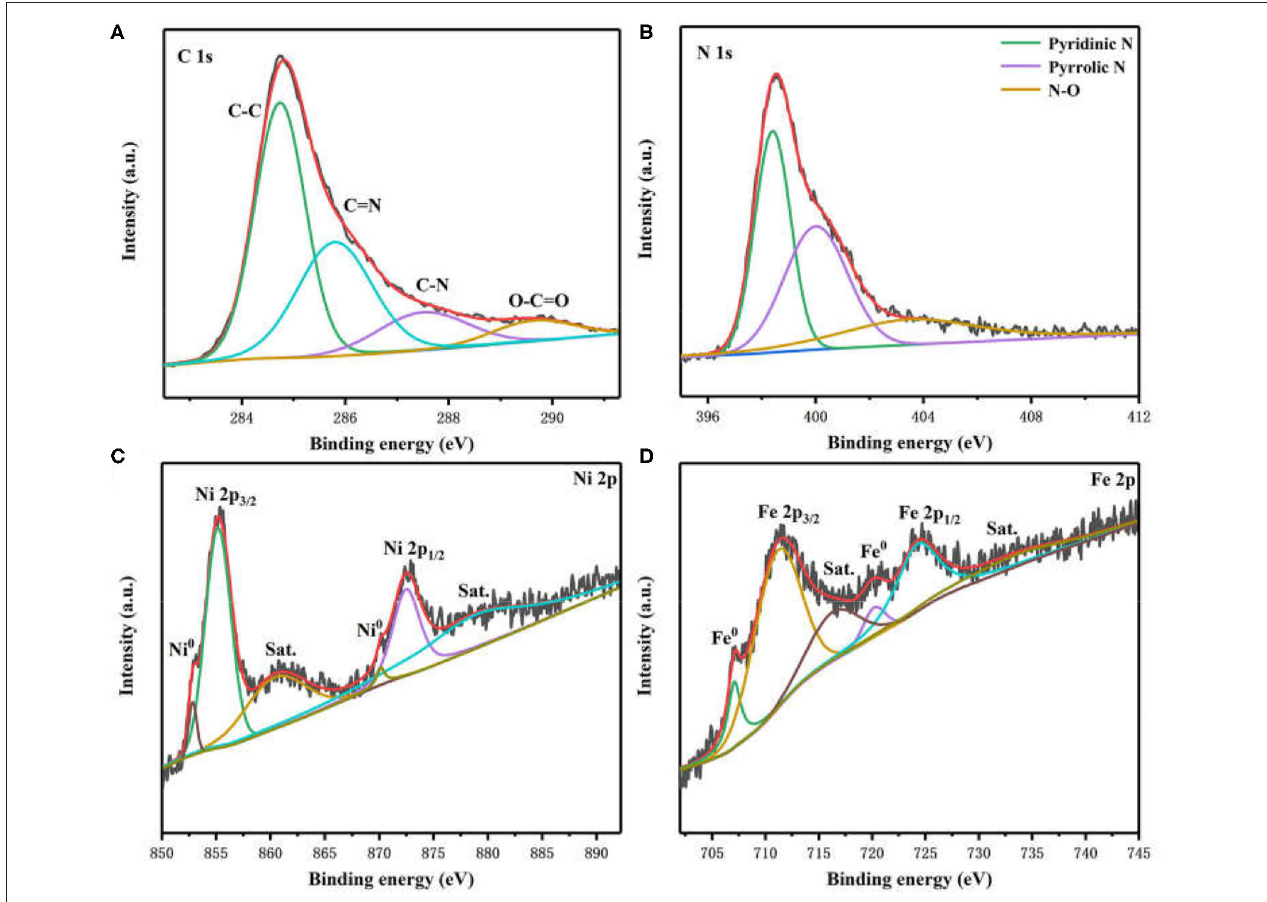
FIGURE 3 | High-resolution XPS spectra of (A) C 1s, (B) N 1s, (C) Ni 2p, and (D) Fe 2p in Ni 3 Fe 2